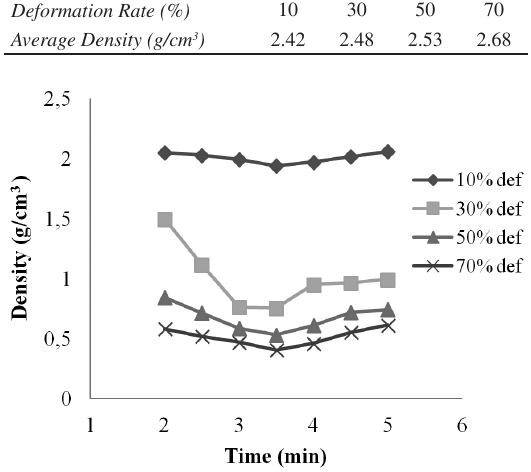
Figure 9. The structure of samples foamed 690 °C.